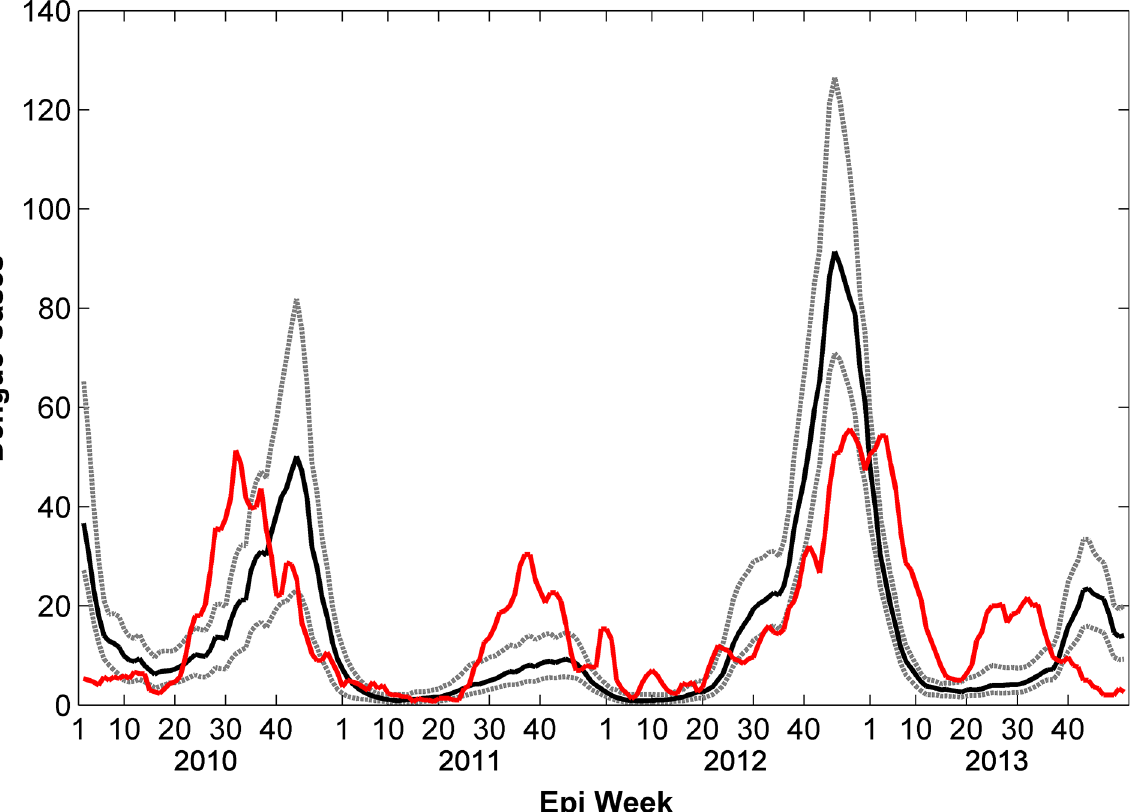
Fig 2. Simulated and reported weekly total dengue fever cases (2010 – 2013). The model ensemble mean (black line) replicated inter-annual variability in reported DF cases (red line) accurately, however, intra-annual variability is not simulated as well. Dashed gray lines are the ensemble minimum and